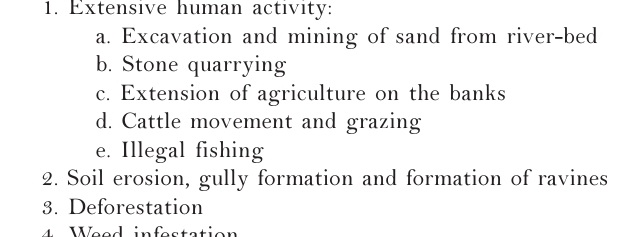
Table 2. Sighting of crocodilians during the Chambal River Expedition in 1998